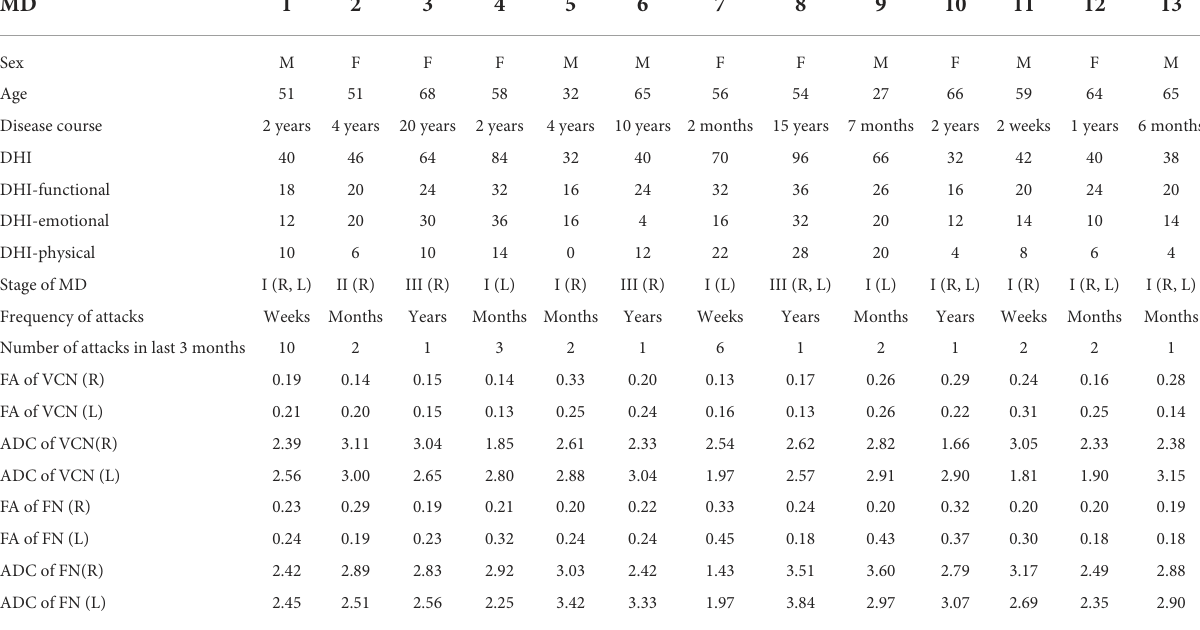
TABLE 1 Clinical information and diffusion tensor imaging (DTI) parameters of MD patients. MD